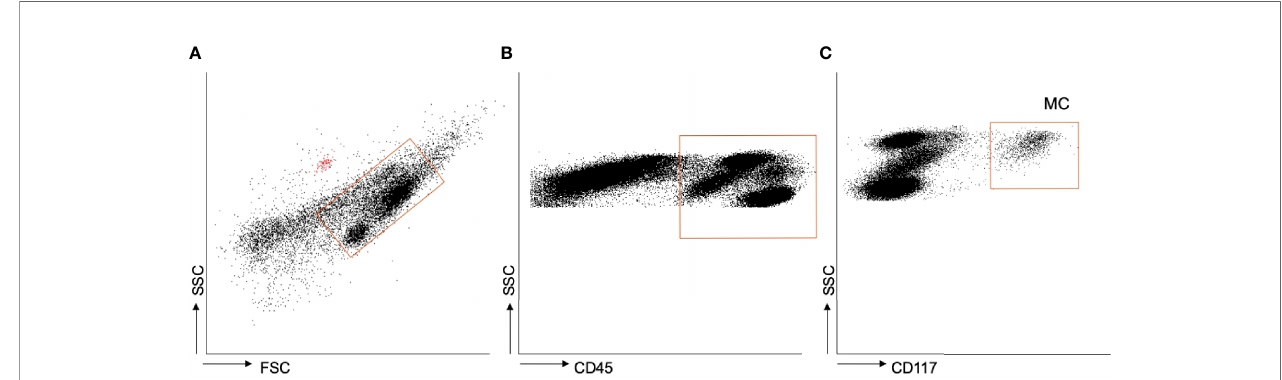
FIGURE 1 | Flow cytometry. (A – C) Gating strategy employed to identify mast cells in adipose tissue. The red dots in plot A are the auto fl uorescent beads employed as